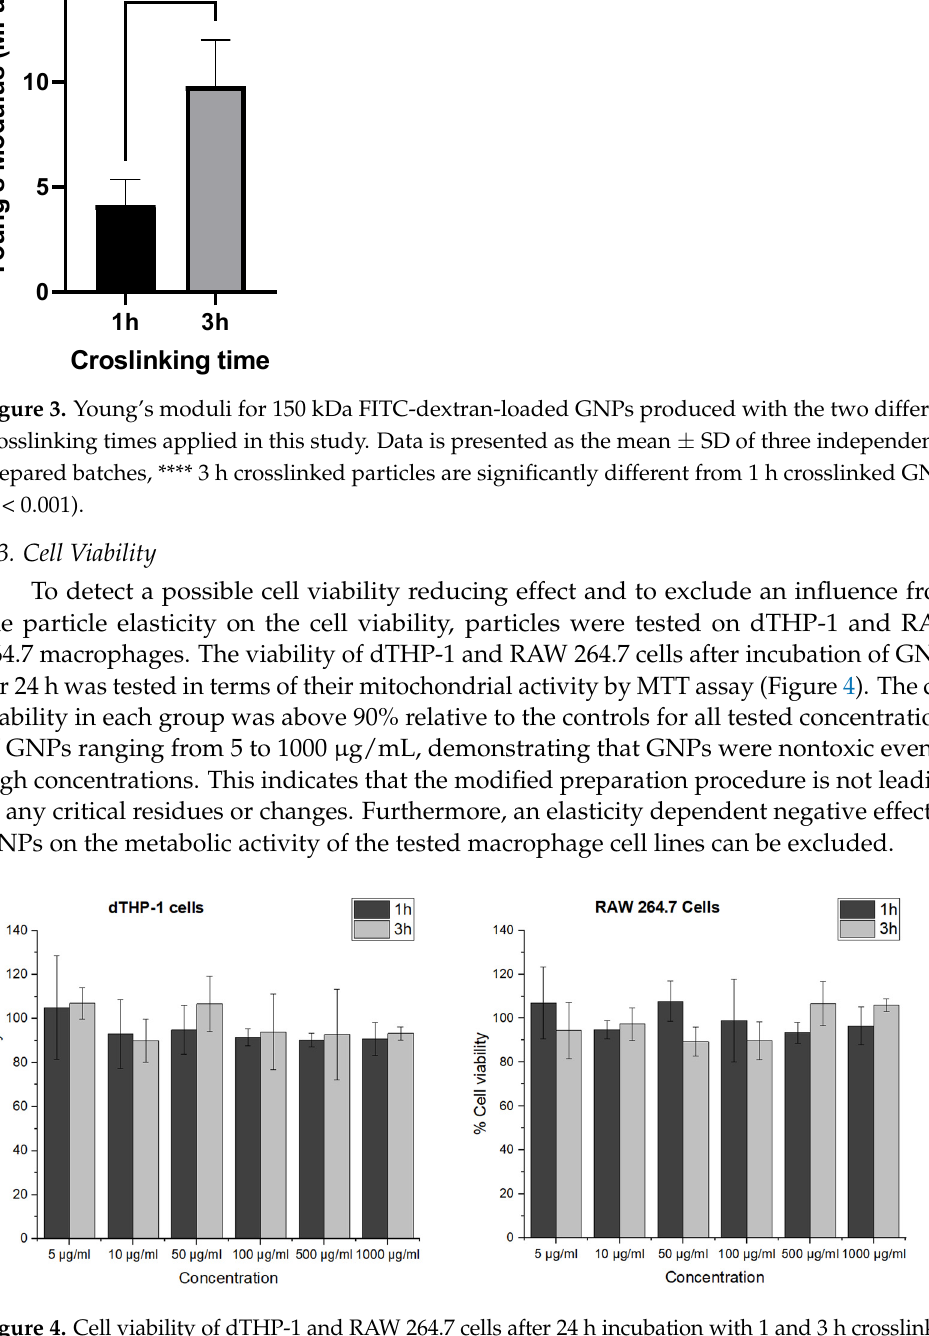
Figure 4. Cell viability of dTHP-1 and RAW 264.7 cells after 24 h incubation with 1 and 3 h crosslinked GNPs determined by MTT assay. The data represent the means ± SD of three independent experiments.